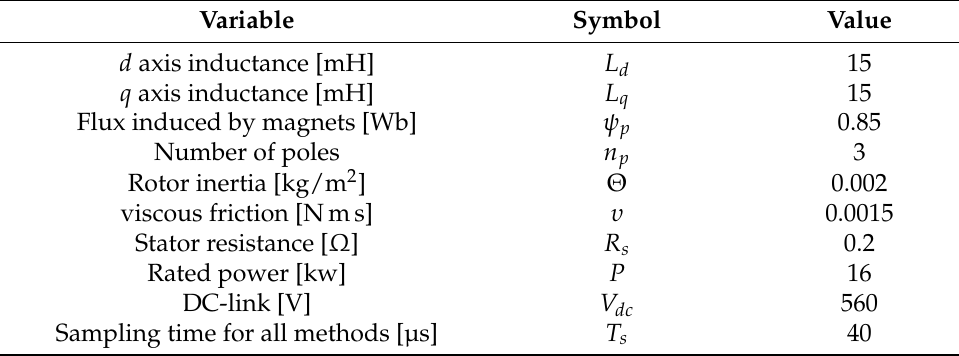
Table 3. PMSM drive